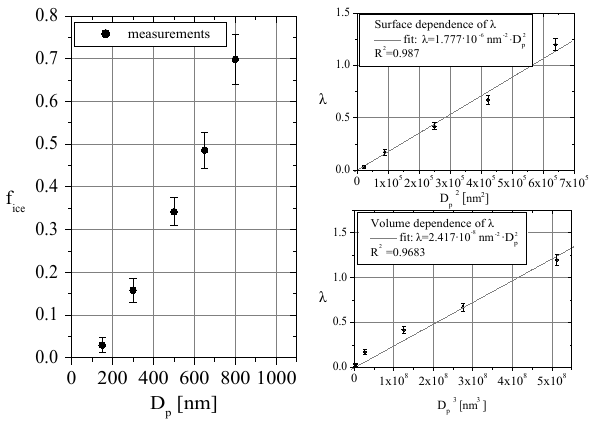
Fig. 3. Ice fraction in the saturation range f ? of the Czech ice birch pollen washing water particles vs. mobility diameter for T = − 35 ◦ C (left panel). Expected value λ of the Poisson distribution describing the average number of INA macromolecules per Czech birch pollen washing water particle as a function of particle surface ( D 2 p ) (upper right panel) and as a function of particle volume ( D 3 p ) (lower right panel). R 2 is the correlation